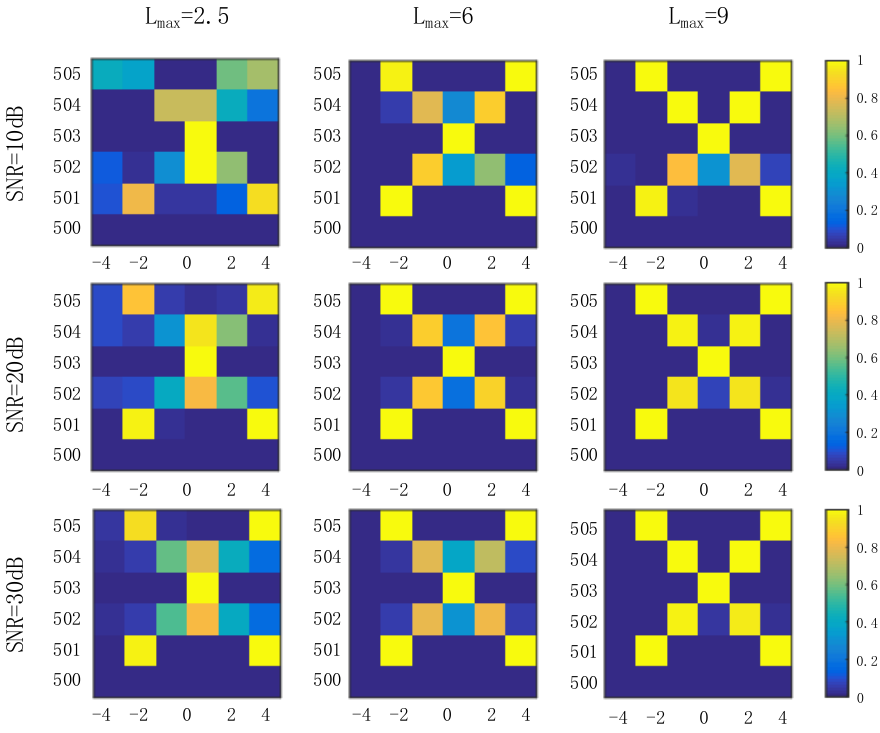
Figure 9. Imaging performance with different SNR and L max